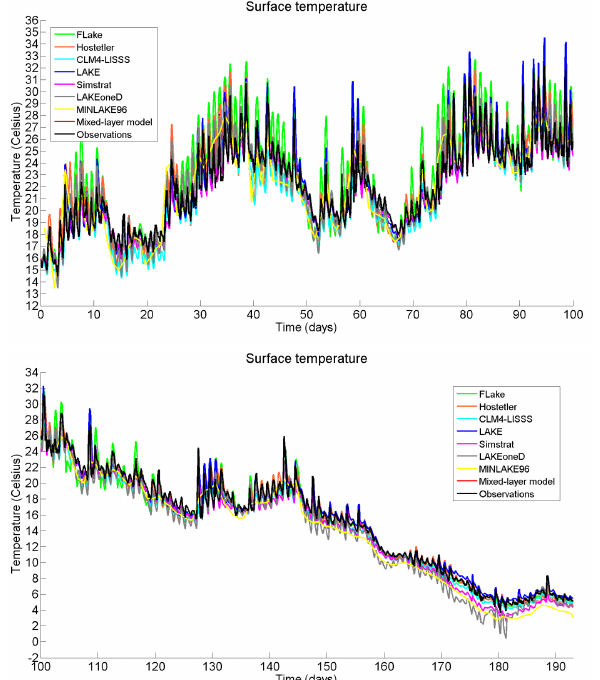
Fig. 2. Time series of mixed-layer temperature of Kossenblatter See by models and from observations. Two panels correspond to two periods – “summer” and “autumn”. The time is counted from 00:00GMT, 1 May 2003.